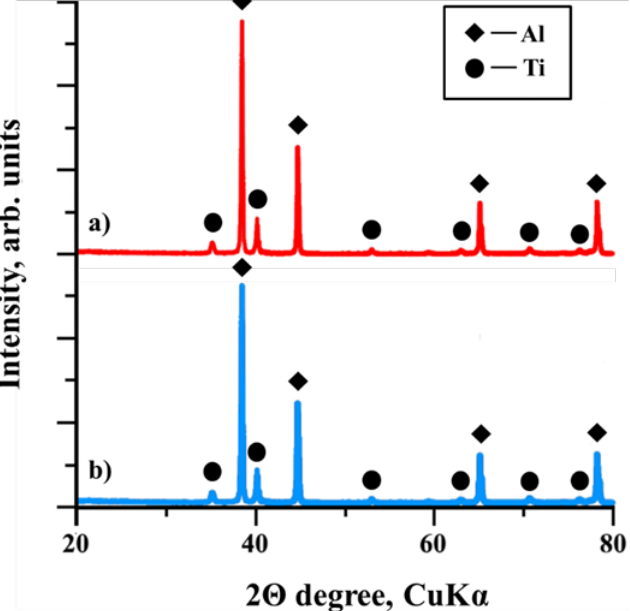
Figure 4. XRD patterns of the Al-Ti-B powder mixture: ( a ) before mechanical activation and ( b ) after 900 s of mechanical activation. 900 s of mechanical activation.